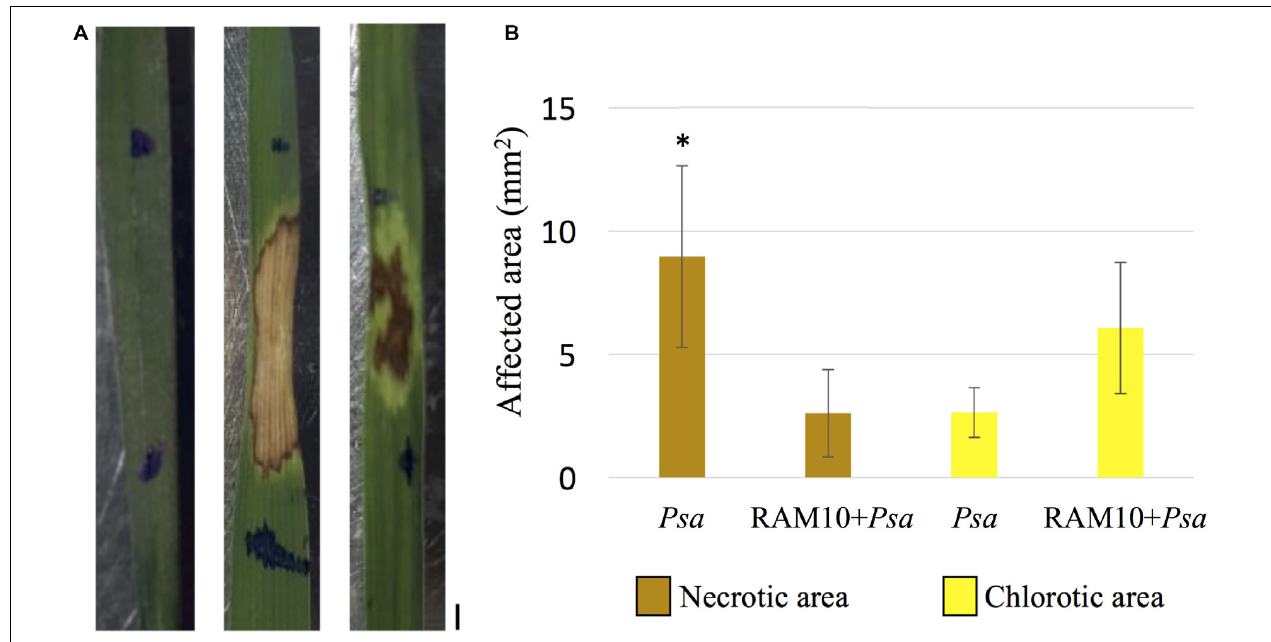
FIGURE 1 | (A) Disease symptoms in Psa (center) and RAM10 + Psa plants (right) 24 h post-infiltration of Psa in the center of the 1st leaf; control plant (C) is shown at left; scale bar = 1 mm. (B) Necrotic and chlorotic areas composing the affected area in Psa and RAM10 + Psa plants (mean ± 95% CI, corrected for multiple comparisons; asterisk indicates significant differences in necrotic area between Psa and RAM10 + Psa leaves).